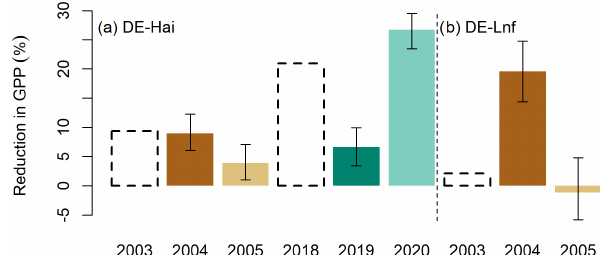
Figure 7. Concurrent (dashed black bars) and lagged (coloured bars) reduction in GPP from the 2003 and 2018 droughts at (a) DE- Hai and (b) DE-Lnf. Concurrent impacts in GPP were quantified as the sum of GPP anomalies over drought periods in drought years relative to averaged total GPP over the growing season (see Sect. 3). Lagged impacts in GPP are characterised as the difference between GPP anom residuals in legacy years and median of the model un- certainties relative to averaged total GPP over the growing season. Coloured bars and error bars show the median and 5%–95%, re- spectively, of lagged reduction in GPP from ensemble model